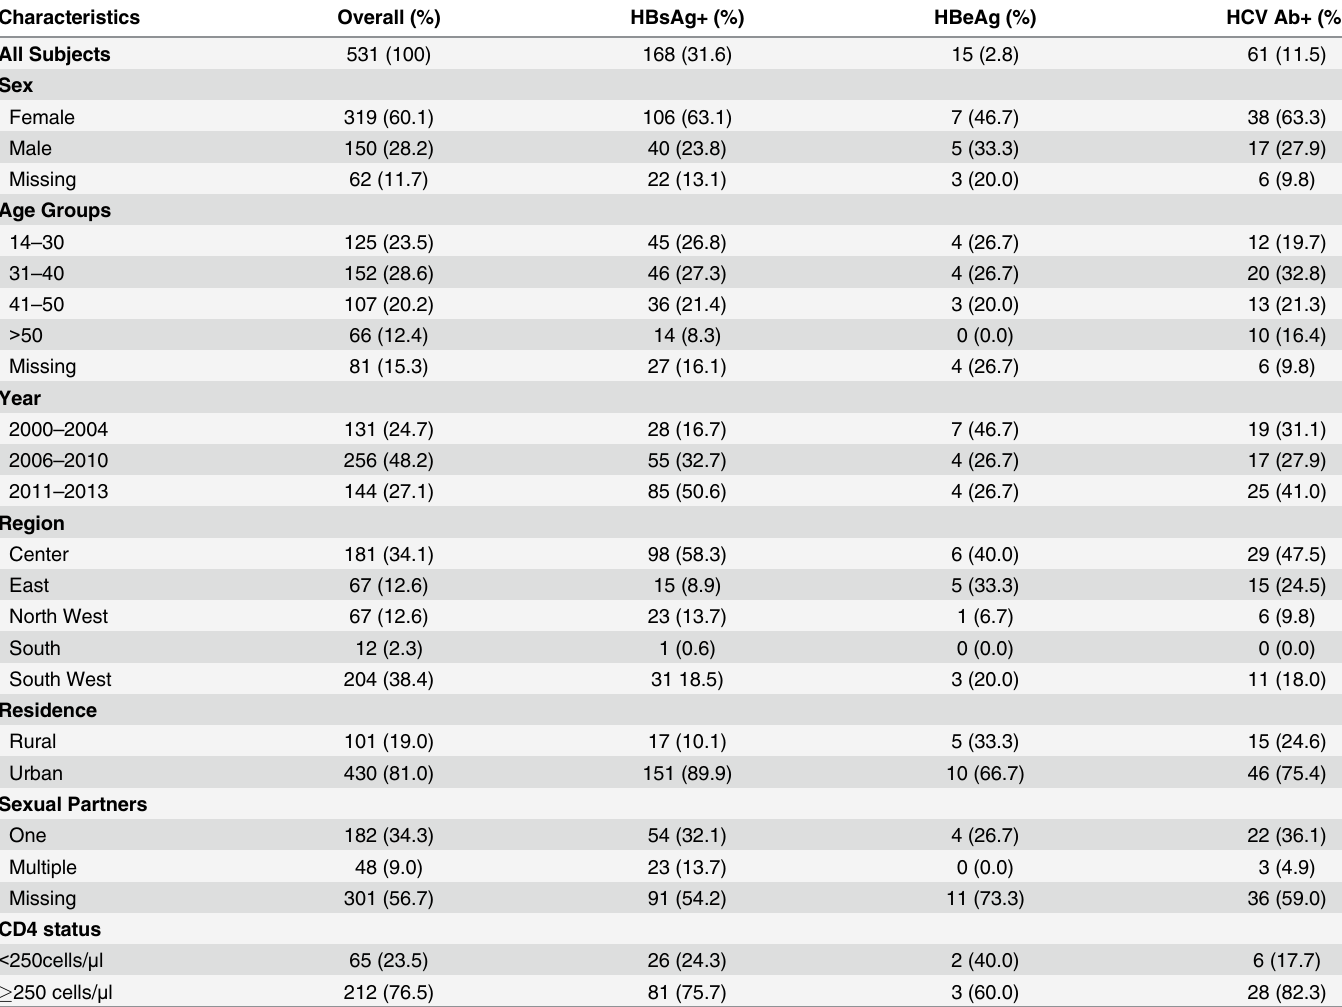
Table 1. Demographic and serology characterization of